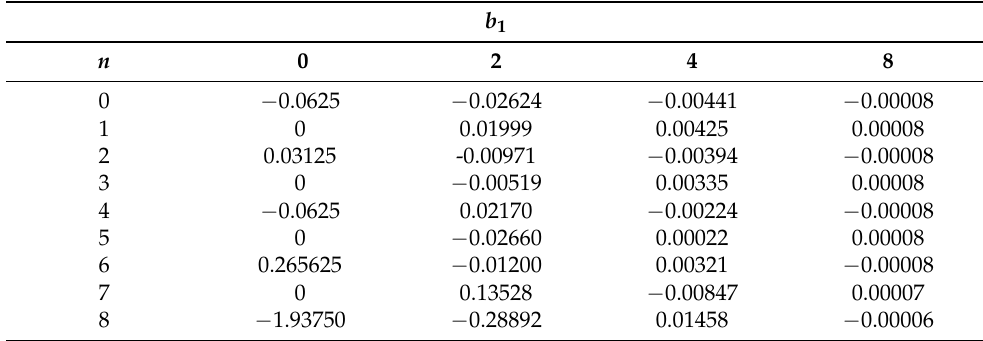
( W n f )( a , b ) for logistic h 1 )